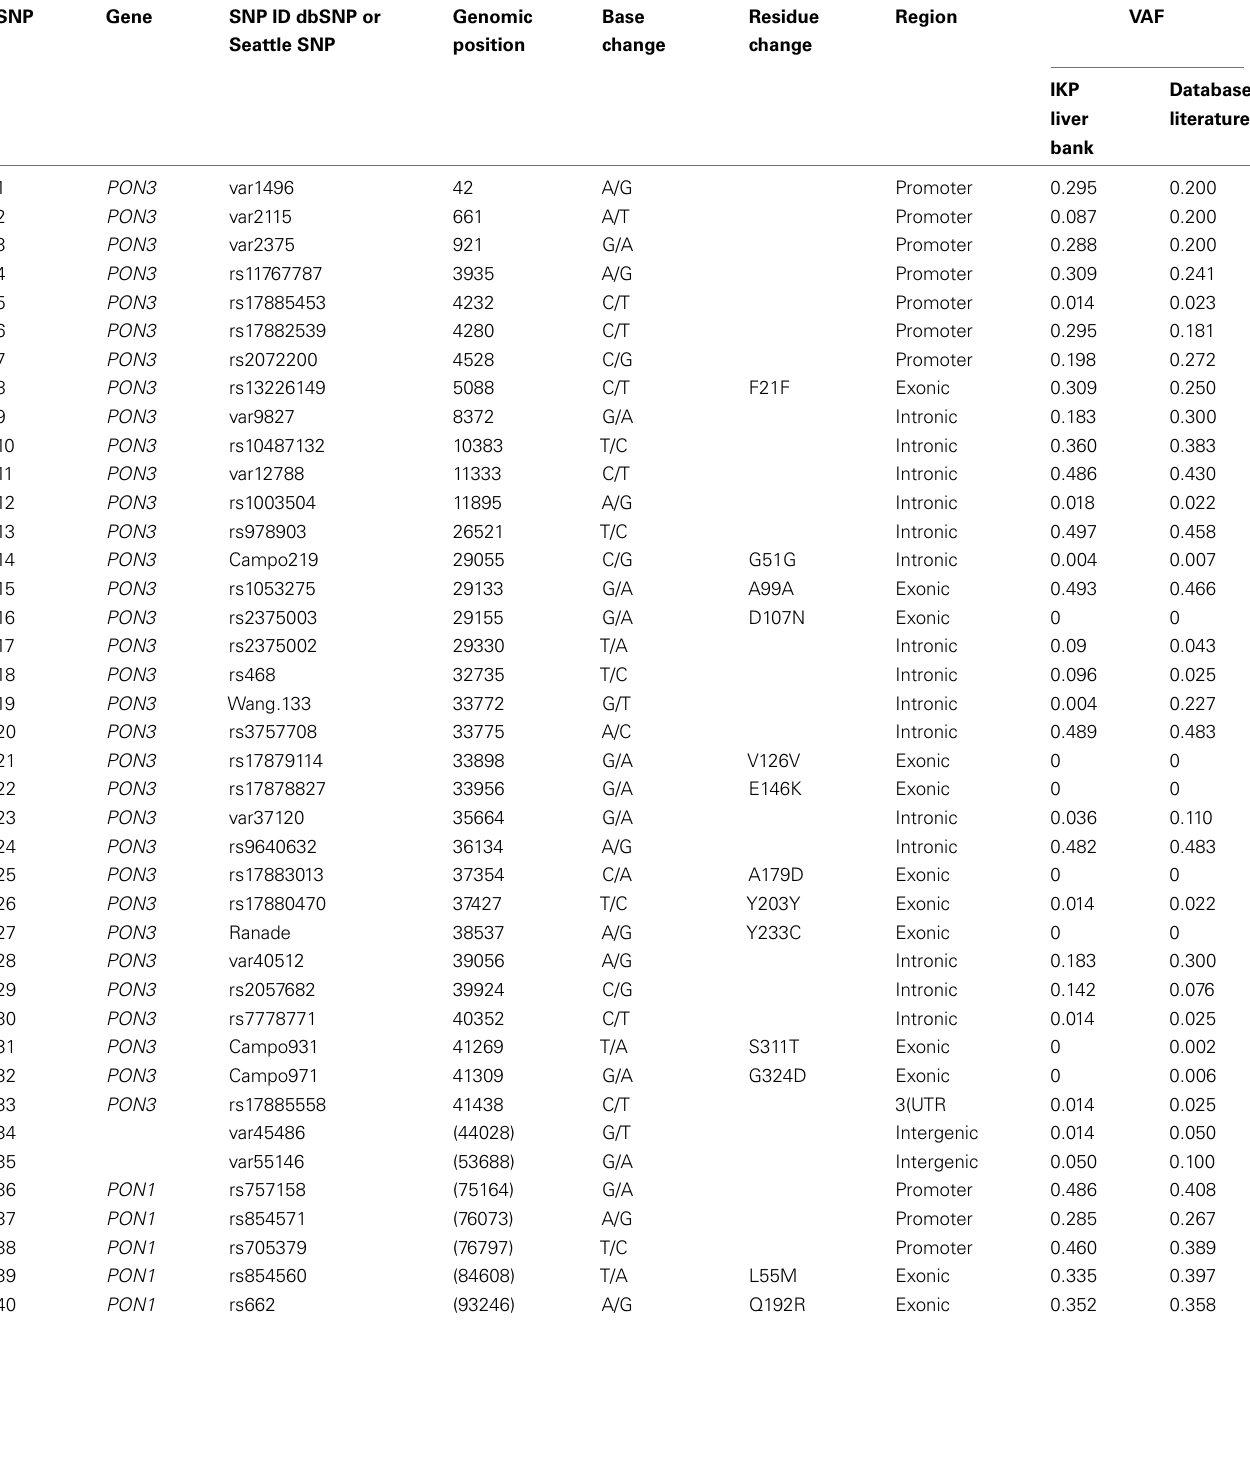
TableA1 | Characteristics and variant allele frequencies (VAF) of polymorphisms determined in 150 Caucasian